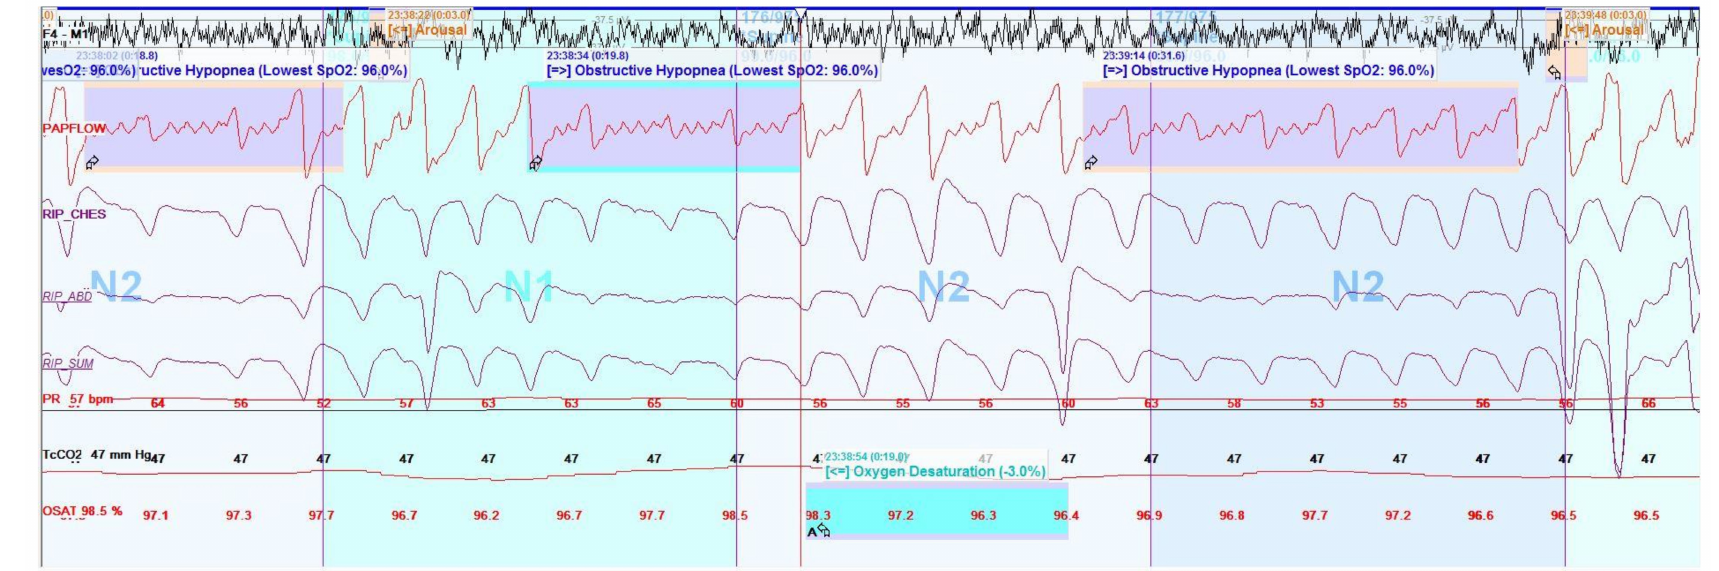
Figure 8. Screen shot (2 min) of selected information derived from a polysomnogram montage demonstrating obstructive hypopneas (smaller deflections in flow signal are cardiac oscillations, not flow). F4-M1 represents electroencephalogram (EEG) signal; PAPFLOW represents flow signal from non-invasive positive pressure therapy sensor; RIP-CHES, RIP-ABD, and RIP-SUM represent inductance belt signals; Tc CO 2 represents transcutaneous sensor reading; OSAT represents oxygen saturation